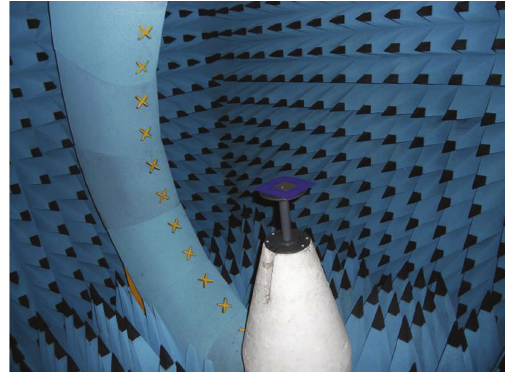
Figure 10: Antenna’s measurement setup in Satimo stargate SG 32 anechoic chamber.